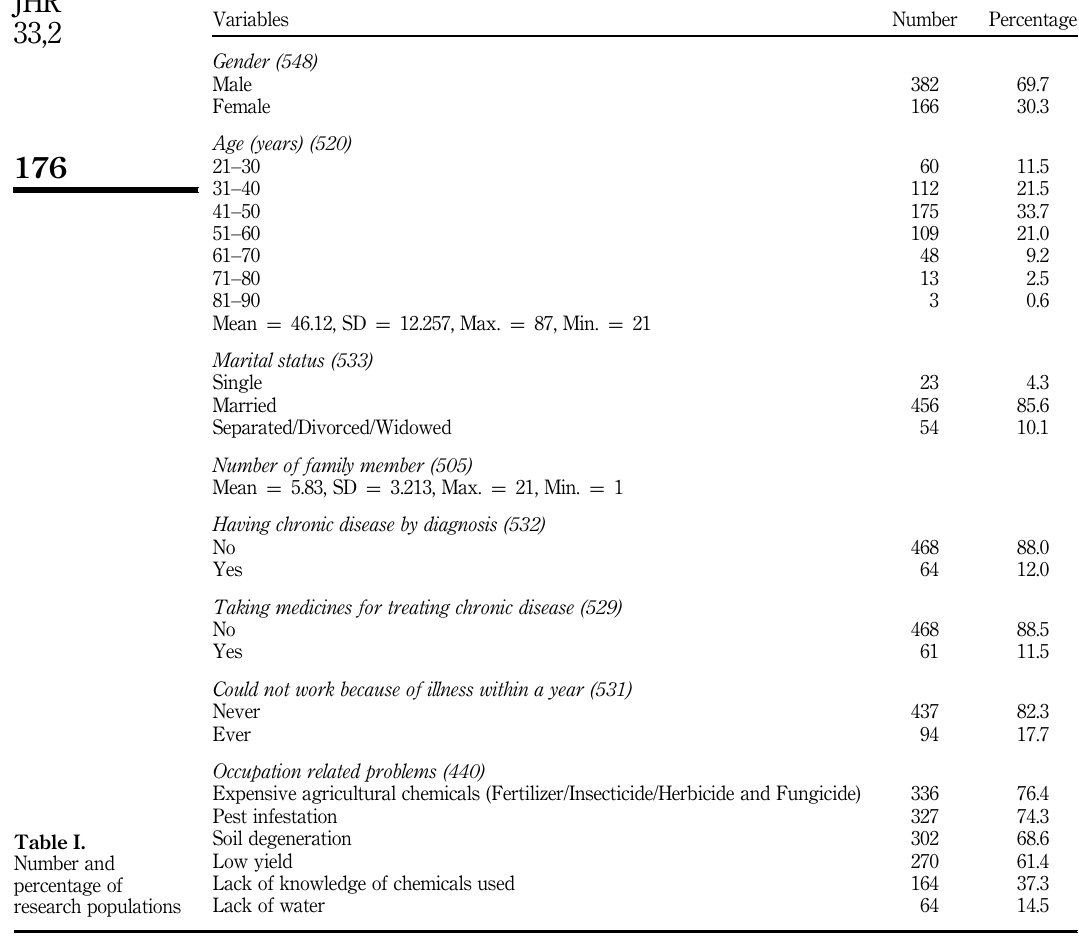
percentage of research populations